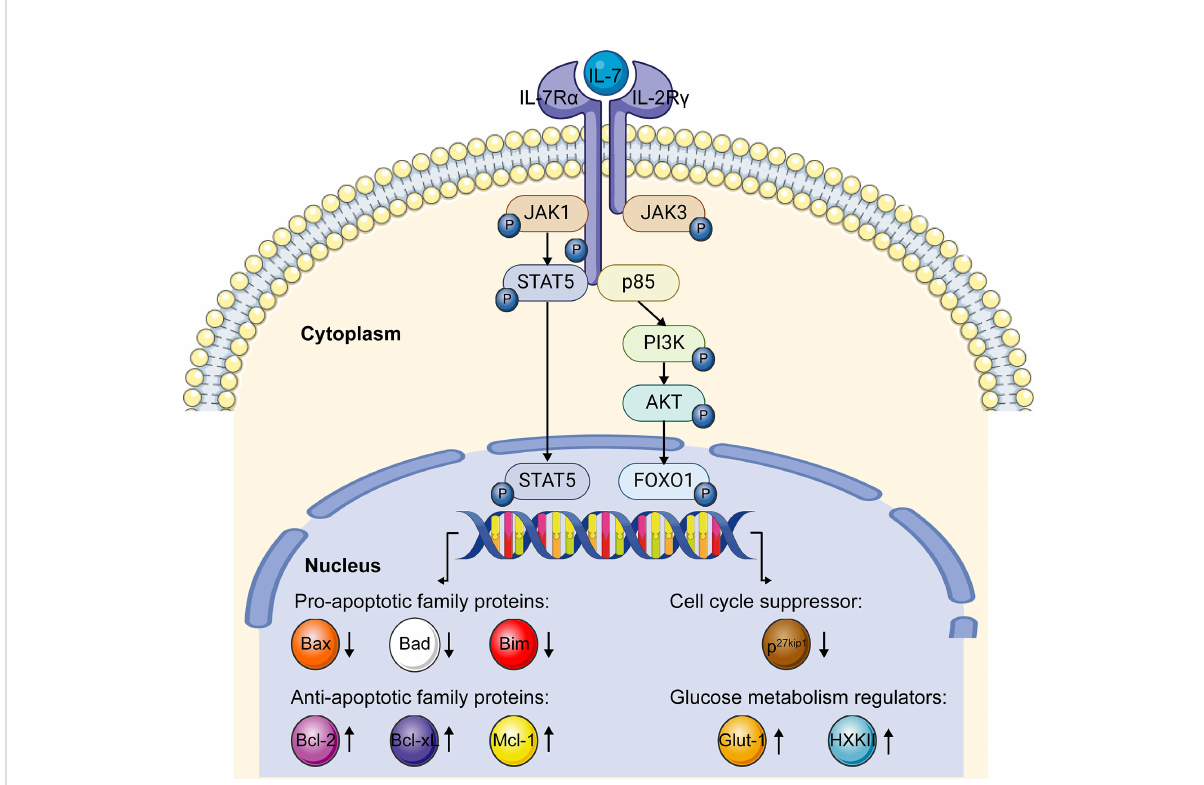
FIGURE 3 IL-7/IL-7R signaling pathway. When IL-7 interacts with the IL-7R, the a chain and g chain dimerize. JAK1 and JAK3 were recruited to IL-7R a and g chains, separately. After phosphorylation, JAK1 and JAK3 phosphorylate and activate the transcription factor STAT5, which further upregulates anti-apoptotic family genes expression and downregulates pro-apoptotic family genes expression via the JAK-STAT5 pathway. After the interaction of IL-7 and IL-7R, recruited p85 induces the phosphorylation of the cytoplasmic tail of the IL-7R a chain, which further triggers the phosphorylation of the PI3K-AKT pathway. Activated PI3K-AKT signaling induces glucose metabolism regulator genes expression and impedes the expression of cell cycle suppressor p27kip1 via FOXO1. This fi gure is created with BioRender.com and